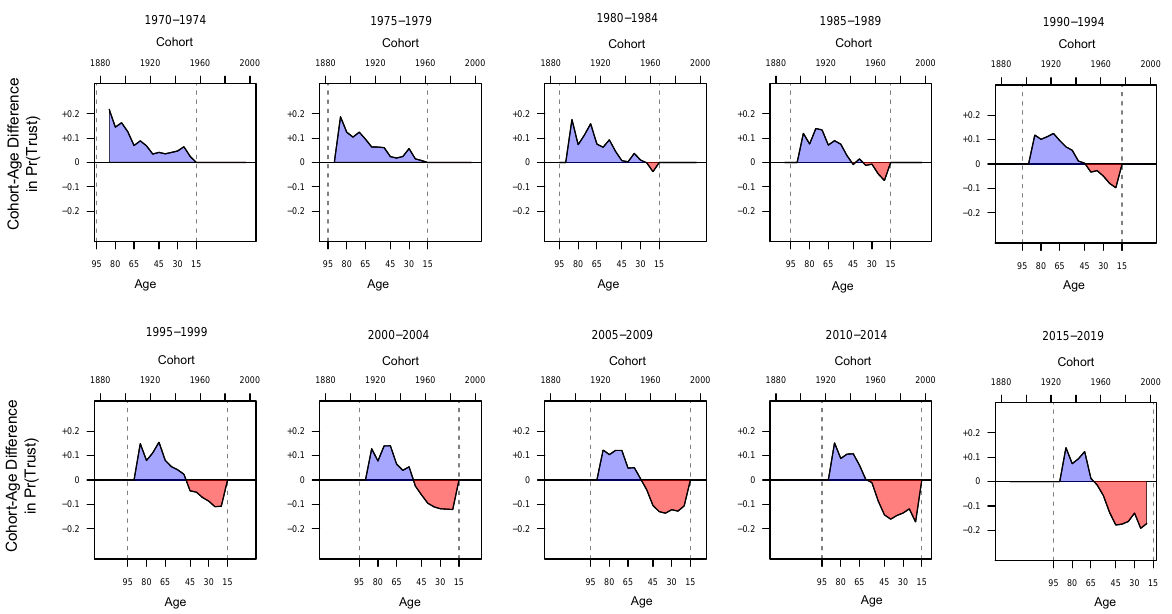
Figure 16: Trellis plot of local synchronic cohort differences. Notes: Each panel displays the difference in predicted probability of social trust for designated pairs of cohort and age levels. Calculations are based on ( θ − θ )( k − k ∗ ) + ( γ k − α j − k + I ) for k = 1, . . . , K in each period j . Top horizontal axes are cohort in years, 2 1 bottom horizontal axes are age in years, and vertical axes are the difference in the predicted probability of social trust. The pairs of age and cohort levels that are compared vary based on age, which is a sliding (cid:101) (cid:101) window across periods. Vertical dotted lines denote the beginning and end points of the age window in each period. Positive (or negative) values indicate that, for particular cohort–age comparisons in a given period, parameters representing social change are greater (or less) than those for life-cycle change. All estimates are based on the cohort synchronic L-APC logistic regression model. Outcome is social trust, coded so that 1 = “can trust” while 0 = “can’t be too careful” or “depends.” Results adjusted using sampling